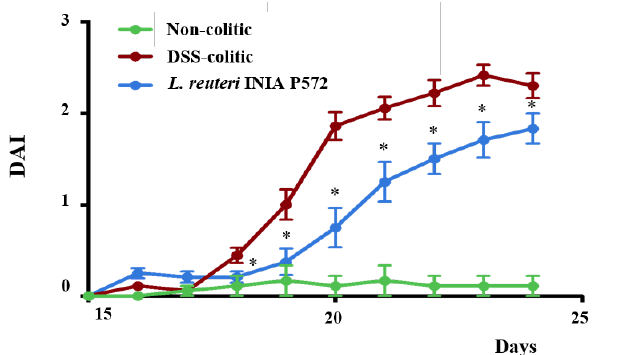
Figure 3. Effects of L. reuteri INIA P572 on disease activity index (DAI) values in Dextran Sulphate Sodium (DSS) colitic mice over the experimental period. Data are expressed as mean ± SEM ( n = 10). Both colitic groups significantly differ from the non-colitic group ( p < 0.05). * P < 0.05.